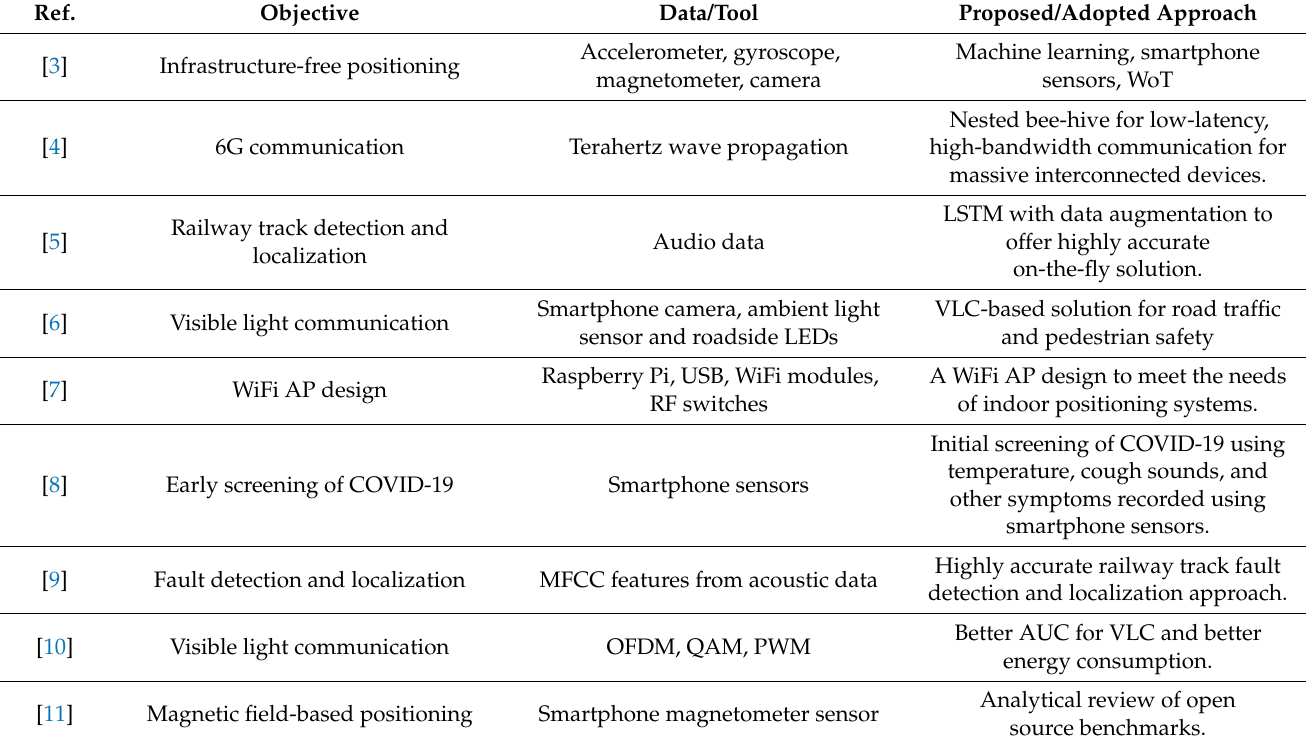
Table 1. Analytical overview of the research works published in the Special Issue.